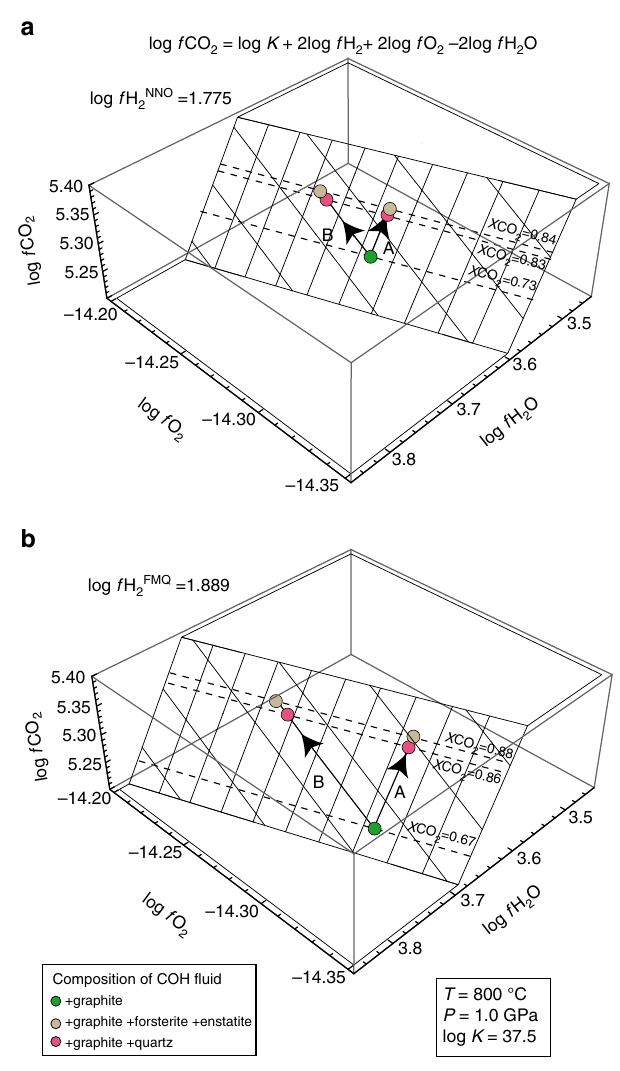
Fig. 3 Model for increased dissolved CO 2 in graphite-saturated fl uids interacting with silicates. 3D plot of the equations log f CO 2 = log K + 2 log f H 2 NNO + 2 log f O 2 − 2 log f H 2 O a and log f CO 2 = log K + 2 log f H 2 FMQ + 2 log f O 2 − 2 log f H 2 O b , assuming log K = 37.5, retrieved from the experimental data and thermodynamic modeling at 1 GPa and 800 °C, using the EoS of Zhang and Duan 46 and the H 2 fugacity coef fi cient of Connolly and Cesare 45 . The increase in X CO 2 observed experimentally in the systems SiO 2 – COH ( pink dots ) and MgO – SiO 2 – COH ( ochre dots ), compared to the pure COH system ( green dots ), can be achieved either by decreasing f H 2 O (arrays A; preferred interpretation) or by increasing f O 2 (arrays B; unlikely because of the lack of Fe and other redox sensitive elements in the considered silicates). The decrease in f H 2 O is ascribed to